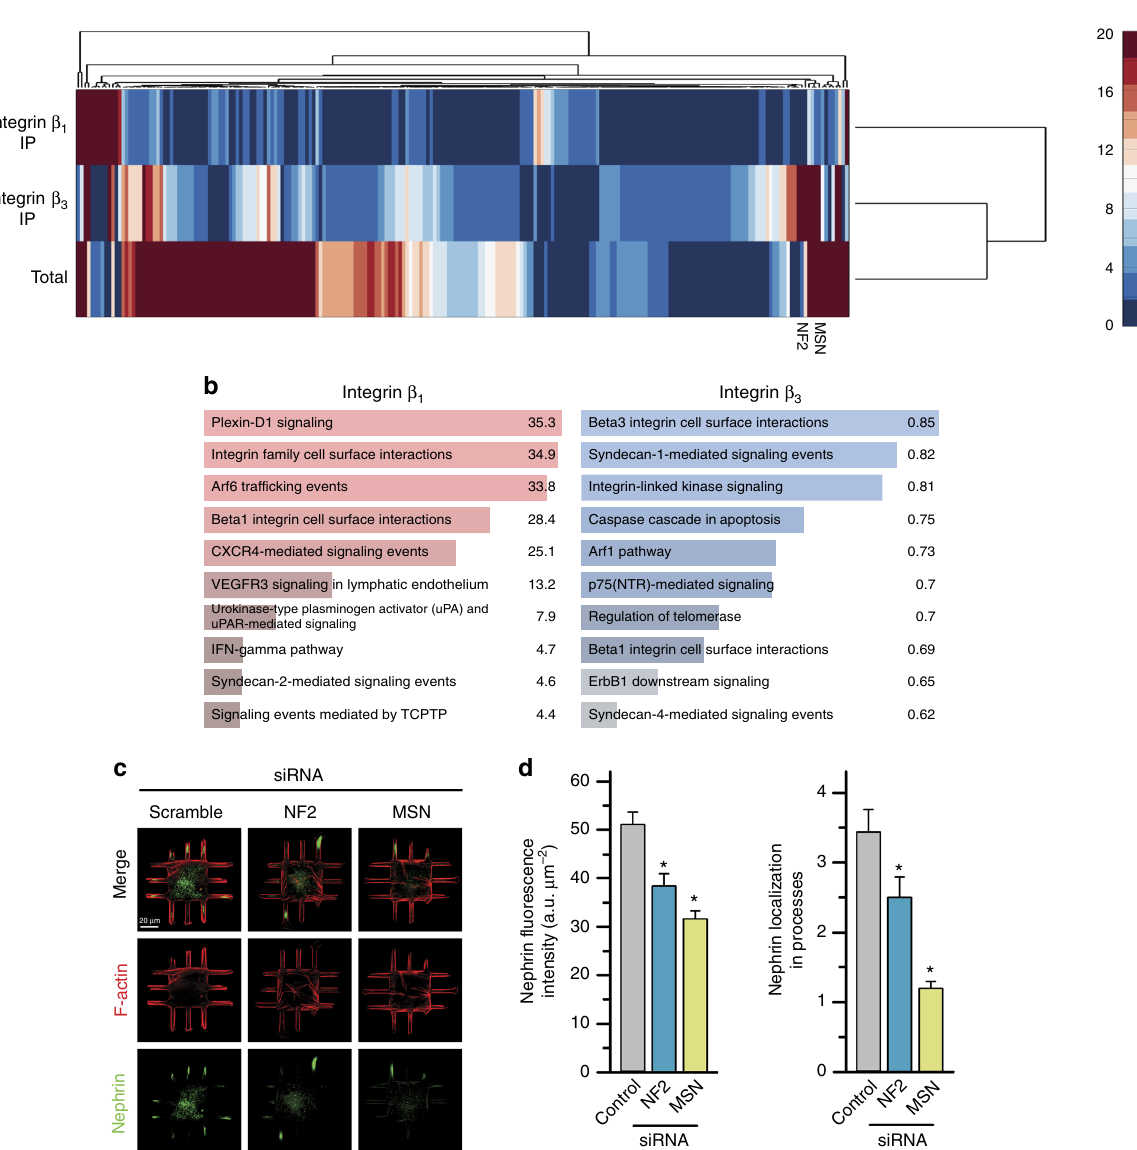
Fig. 6 Integrin β 3 acts through ezrin – radixin – moesin (ERM) family to transduce shape signals. a Dendrogram depicting the preferential binding partners of β β 1 and 3 as characterized by mass spectrometry. Cell lysates from kidney podocytes were immunoprecipitated (IP) using monoclonal antibodies for the respective integrin isoforms and ran through label-free proteomics and quanti fi ed using the spectral counting method. Intensity represents the number of spectra per protein. ERM proteins merlin (NF2) and moesin (MSN) clustered as top differentially bound proteins for integrin β 3 . b Enrichment analysis using NCI-Nature ontological database showed “ Beta1 integrin cell surface interactions ” and “ Beta3 integrin cell surface interactions ” as the highest over- represented processes for the binding partners of the respective proteins. Color-coded bars represent the shown – log10 p value of respective enriched processes. c Representative images of podocytes plated on channel micropatterns and transfected with moesin (MSN), merlin (NF2), or scrambled siRNA, and stained for F-actin (red) and nephrin (green). d Quantitative analysis of (left) whole-cell nephrin intensity and (right) nephrin localization in processes of podocytes plated on channel micropatterns and transfected with scrambled, NF2, or MSN siRNA. Values given as mean ± SEM; n = 80, chosen randomly from four different slides cultured independently (* p < 0.01 vs. untreated control; one-way ANOVA followed by a post hoc Tukey